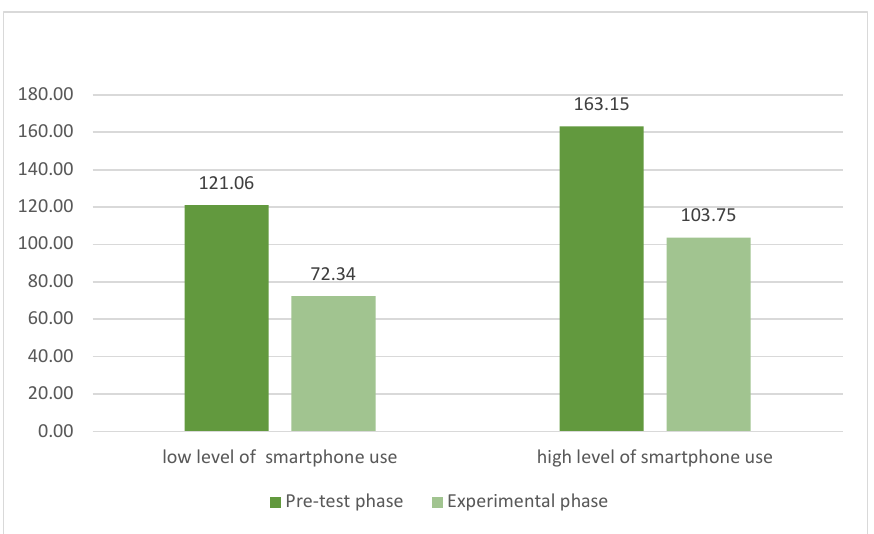
Figure 4. Percentage of participants with and without compliance in the two groups with high and low levels of smartphone addiction.